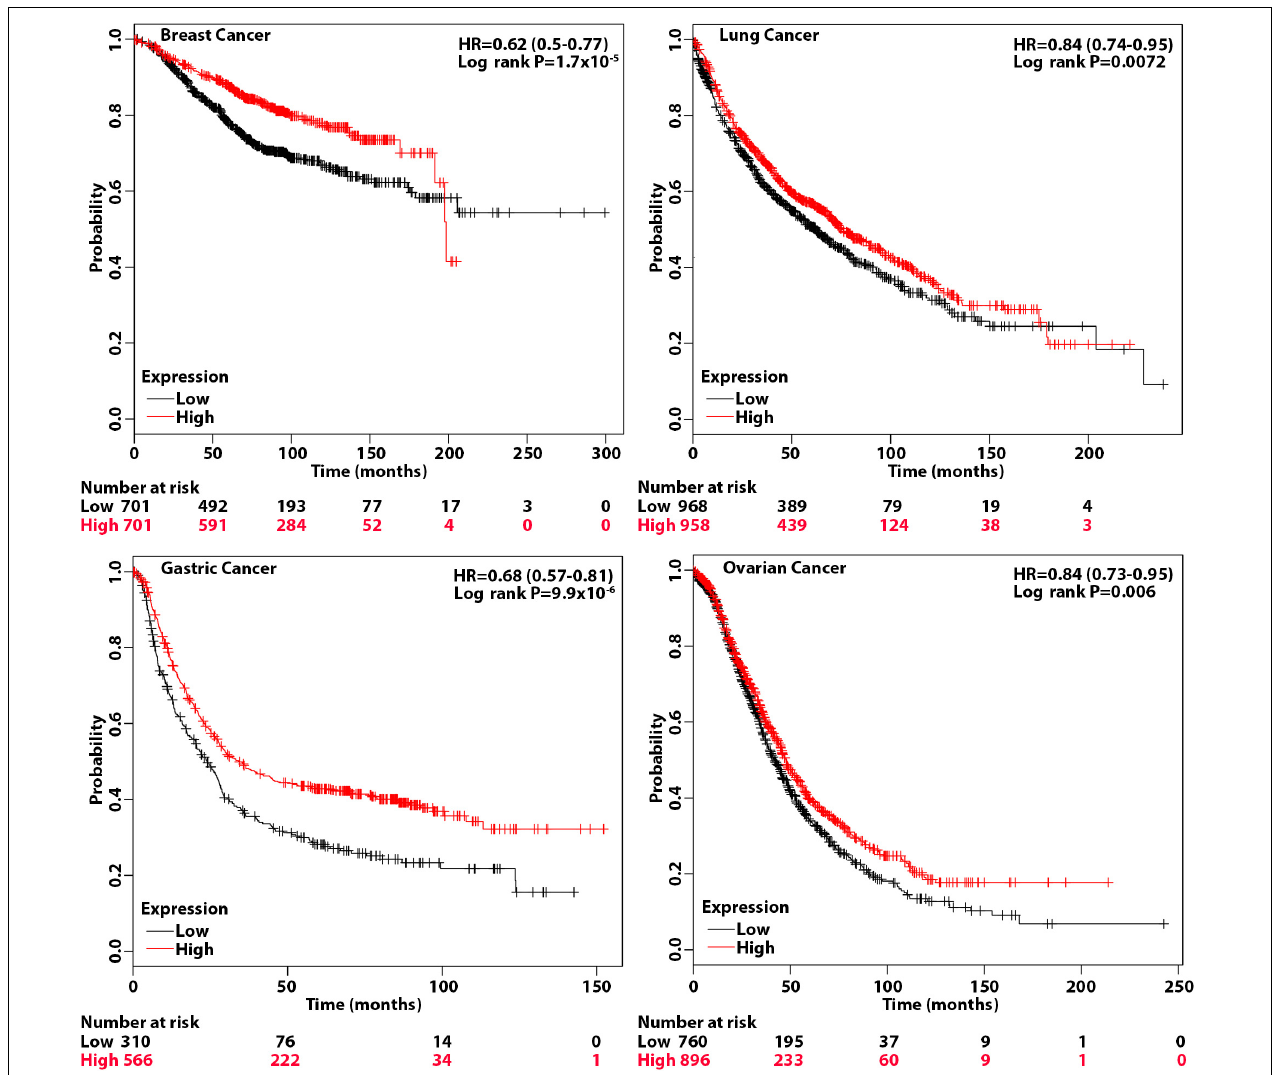
FIGURE 6 | Association of eukaryotic initiation factor (eIF)3a expression with overall survival of breast, gastric, lung, and ovarian cancers. Overall survival analyses were conducted using Kaplan–Meier (KM) plotter with hazard ratio (HR) at 95% confidence intervals and log rank P < 0.05 considered